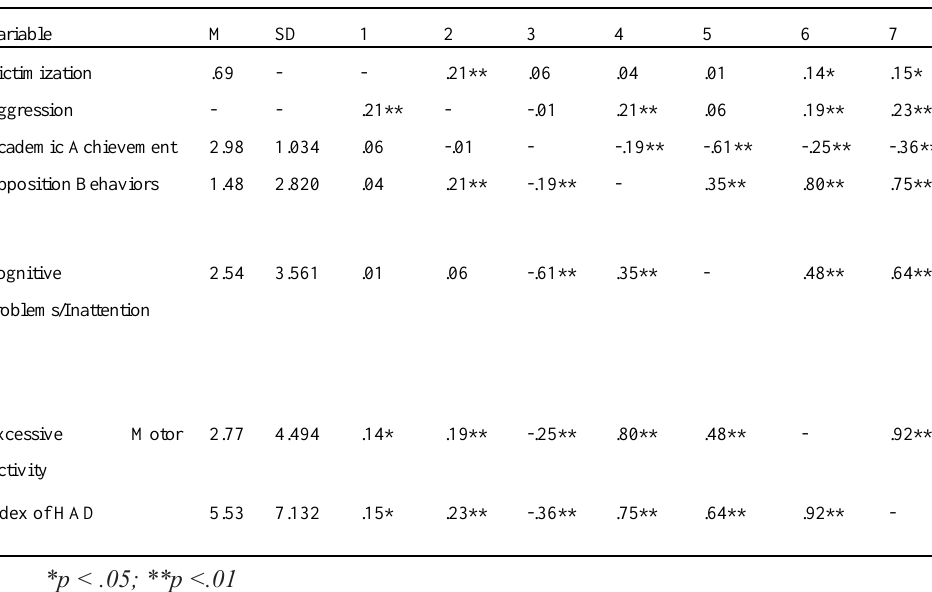
Table 1: Descriptive Statistical